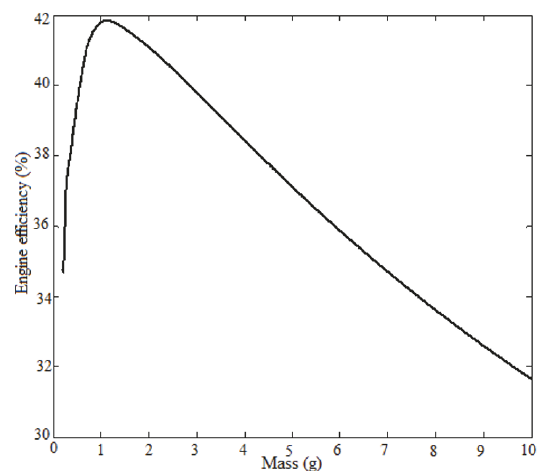
Figure 13: Engine efficiency variation with working fluid mass.